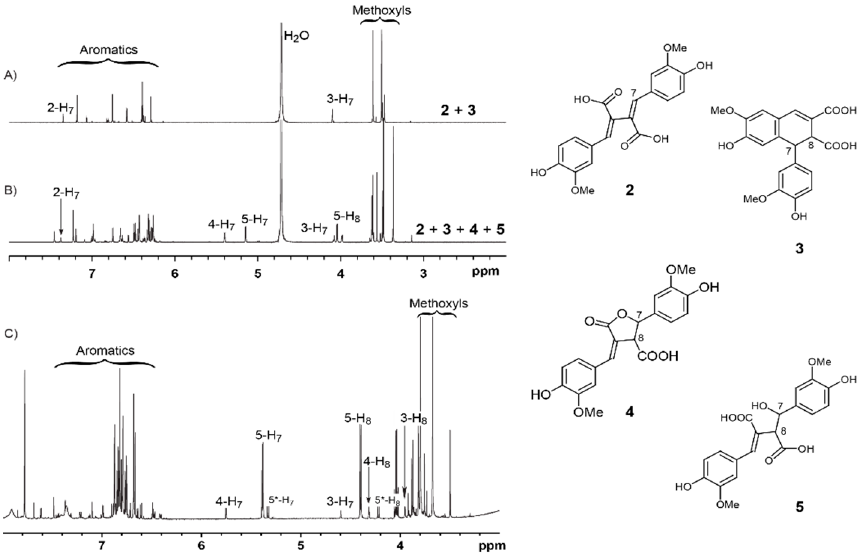
Figure 2. In situ 1 H NMR (in D 2 O) of products from ferulic acid (FA) dilactone treated by ( A ) 1 M Na 2 CO 3 and ( B ) 1 M NaOH. ( C ) 1 H NMR (in Acetone-d 6 ) of crude products recovered from 2 M NaOH treatment of FA dilactone.